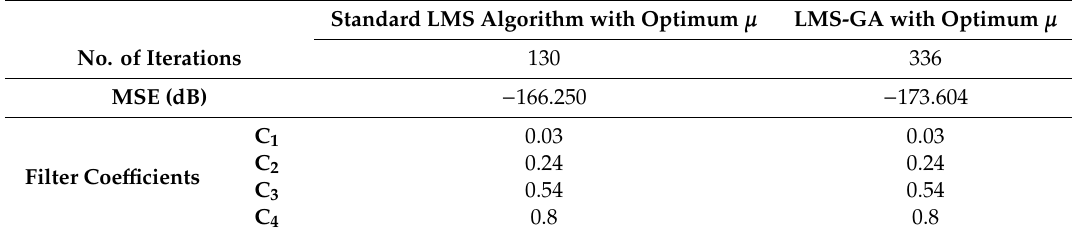
Figure 19. The convergence performance of the LMS-GA tool for adaptive IIR filter.